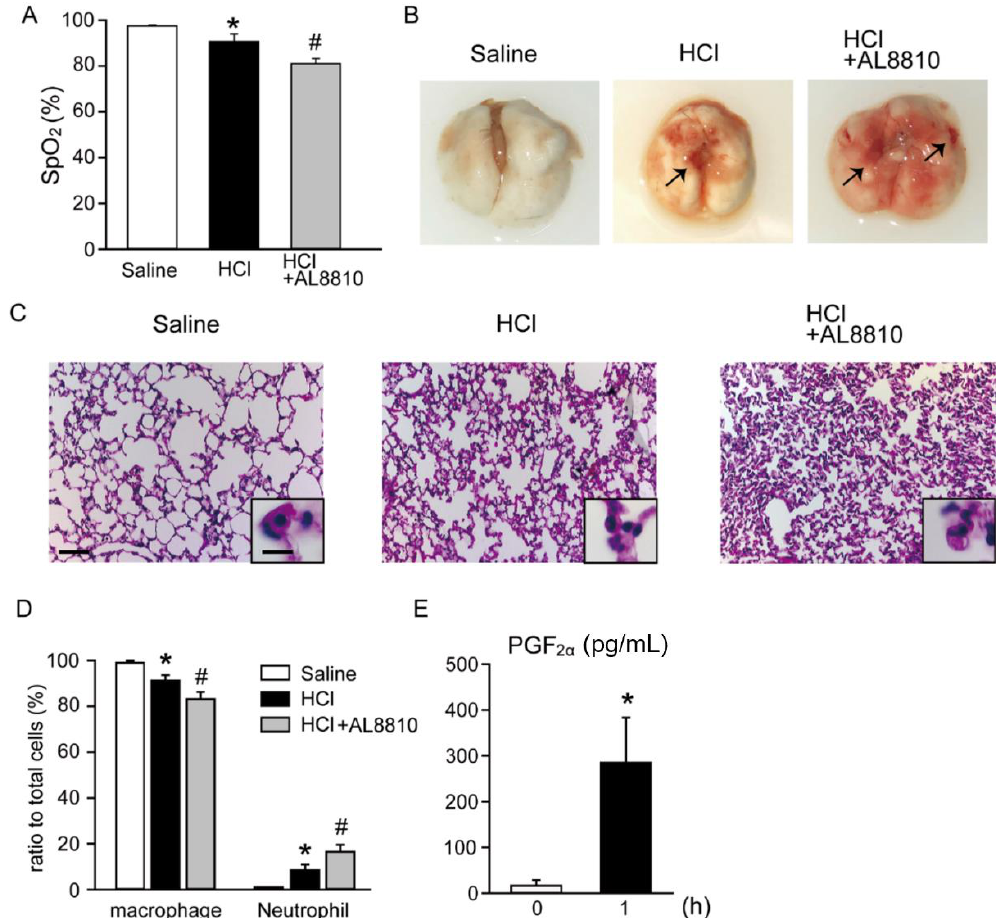
Figure 1. Pretreatment with AL8810 promoted HCl-induced lung inflammation. AL8810 (10 mg/kg, i.p.) was administered to mice 1 h before HCl (0.1 M, 2 µL/g, i.t.) administration. ( A ) SpO 2 level was used as a measure of pulmonary function ( n = 3-4). * p < 0.05 vs. saline, # p < 0.05 vs. HCl. ( B ) Representative images of the lung tissues of saline-, HCl-, and HCl + AL8810-administered mice ( n = 4–8). ( C ) Representative images of HE-stained sections of the lung tissues of saline-, HCl-, and HCl + AL8810-treated mice (scale bar 50 µm) ( n = 6–10). ( D ) The cell numbers in BALF were measured at 6 h after administration of saline or HCl ( n = 5–6). * p < 0.05 vs. saline, # p < 0.05 vs. HCl. ( E ) The PGF 2α levels in BALF were measured by ELISA ( n = 6). * p < 0.05 vs. 0 h.